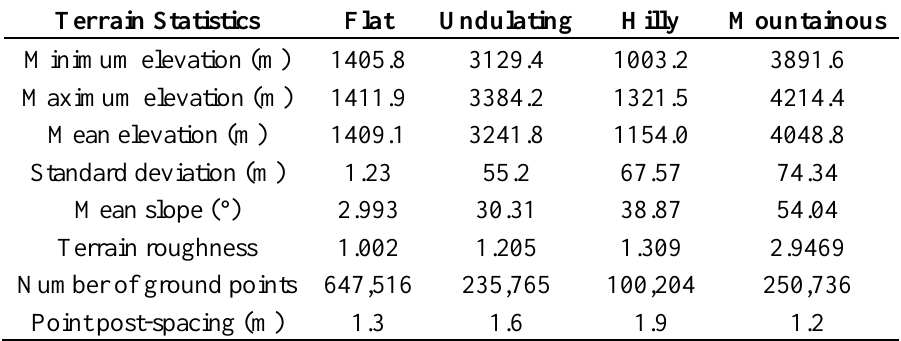
Table 1. Topography characteristics of the four study